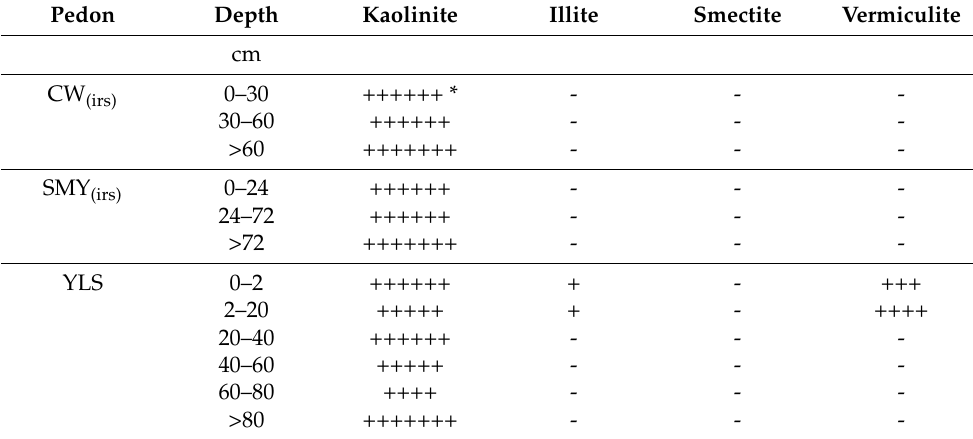
Table 3. Semiquantitation of the CW (irs), SMY (irs) (Penghu Islands) and YLS (Zhangpu, Fujian) soil clay minerals using XRD diffraction analyses. Pedon Depth Kaolinite Illite Smectite Vermiculite